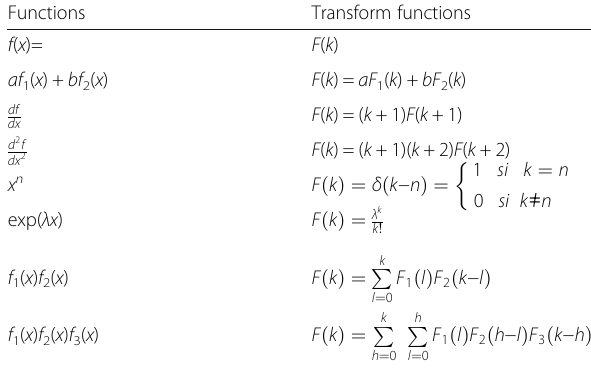
Table 1 One-dimensional DTM fundamental